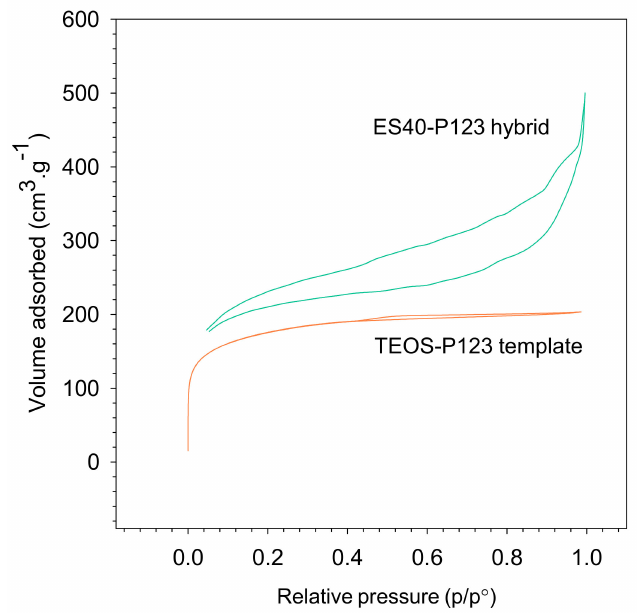
Figure 3. BET adsorption of carbon-templated silica (P123-TEOS) and hybrid organosilica